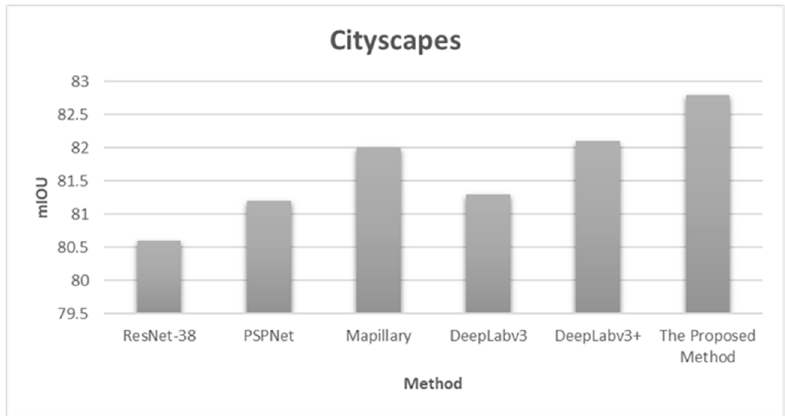
Figure 16. Comparison of the accuracy (mIOU) of the proposed method and methods from the literature on images in the Cityscapes database.